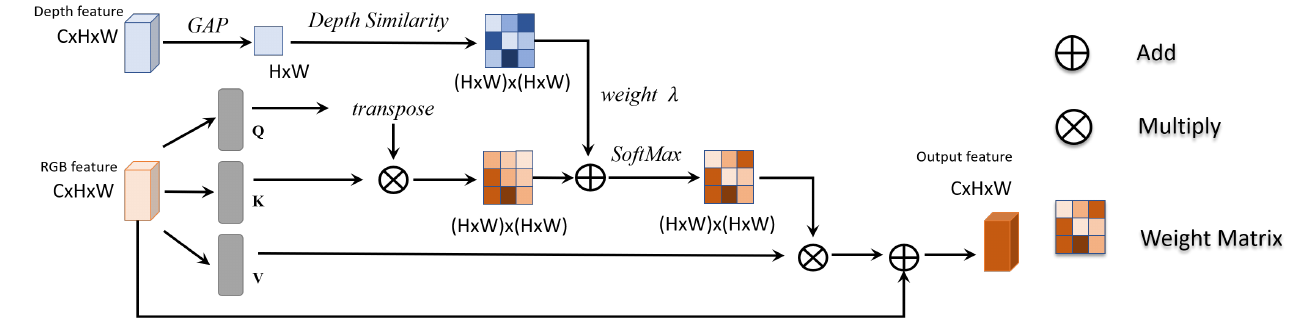
Figure 3. Depth-aware Self-attention Module in an addition